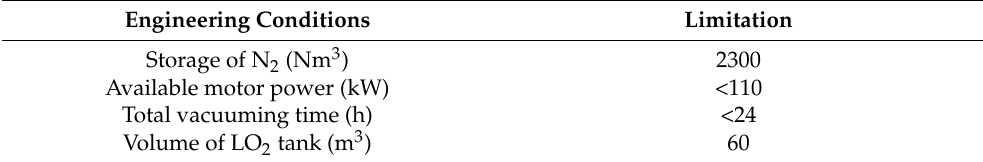
Table 1. Limitations of engineering conditions.